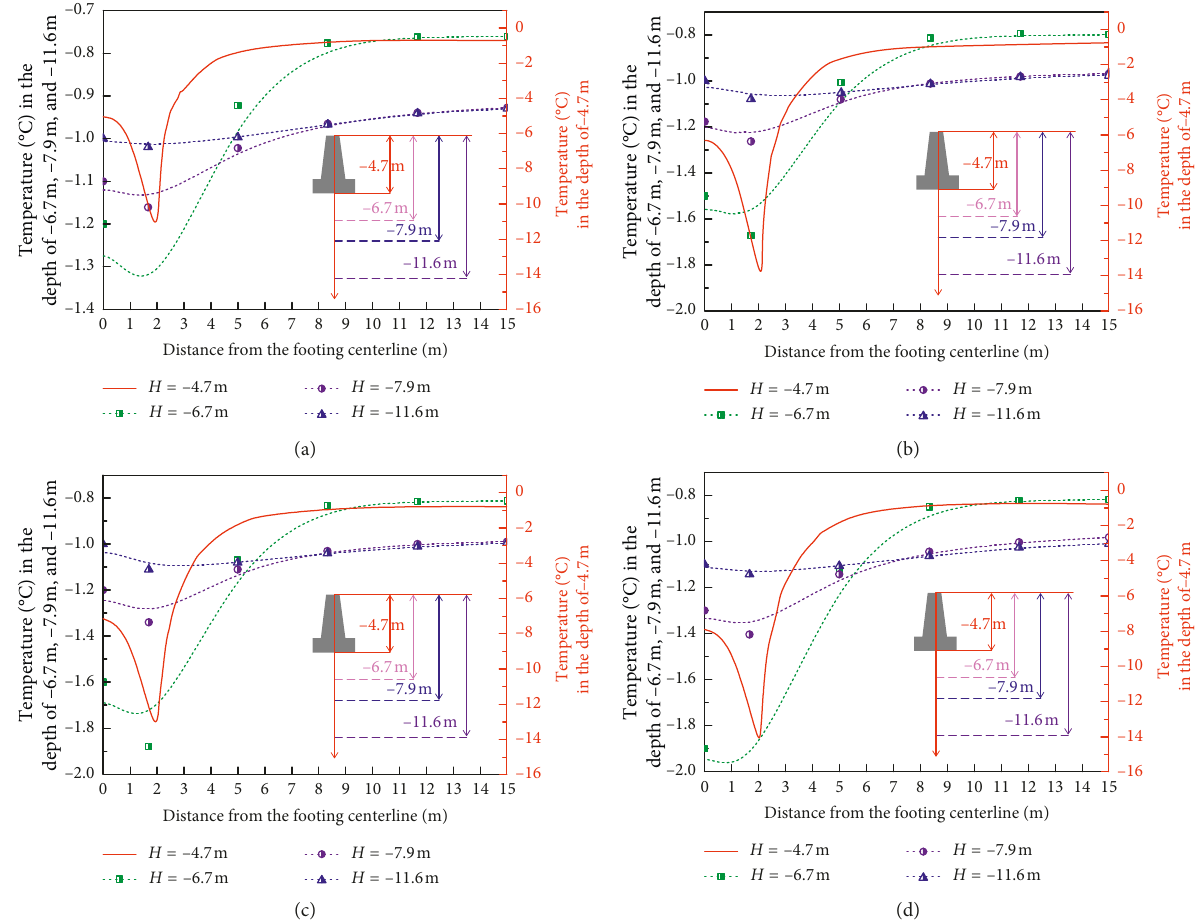
Figure 6: Horizontal temperature distribution at different depths. (a) d